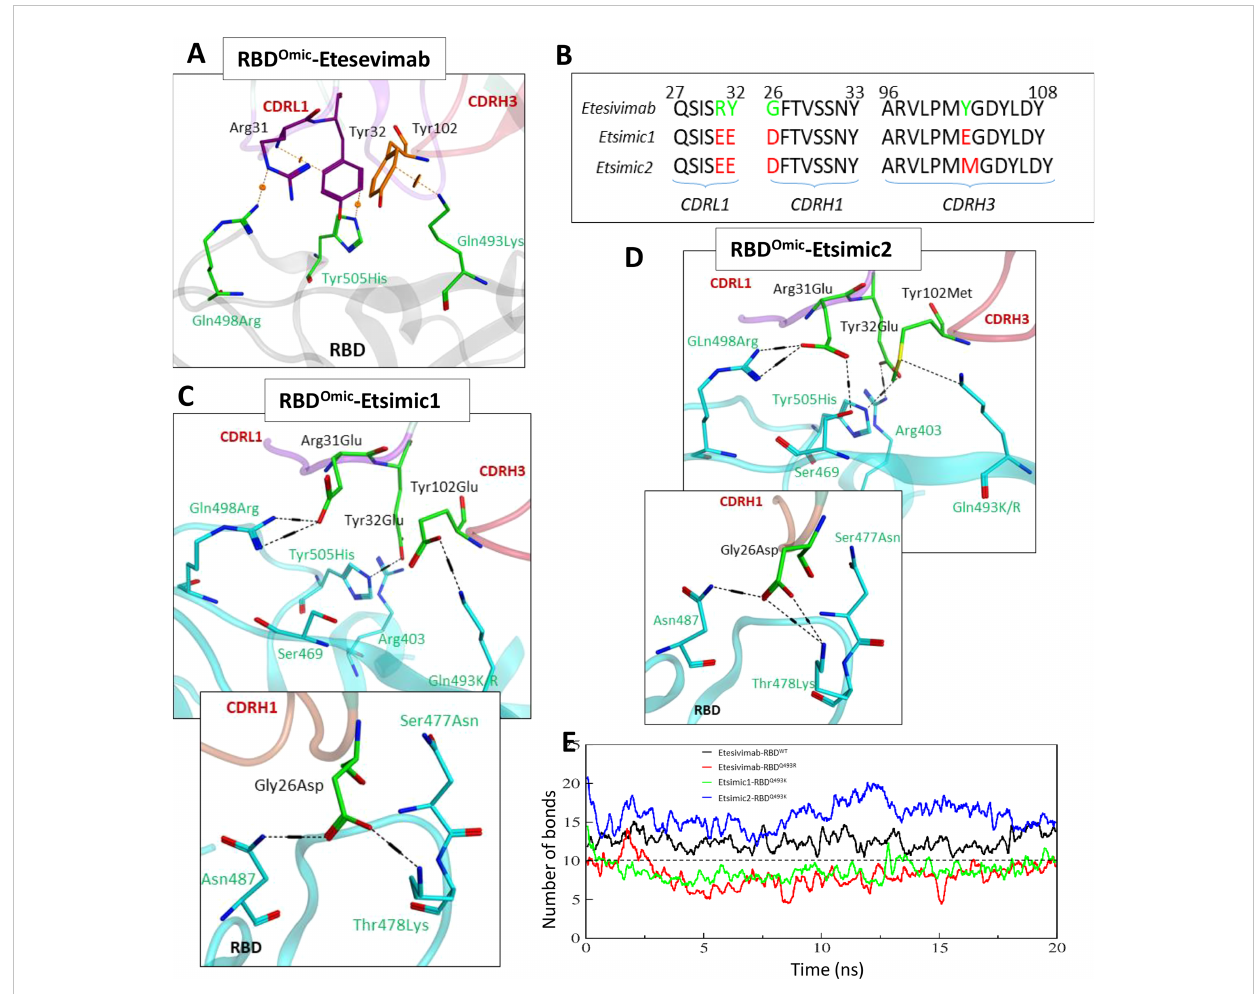
FIGURE 6 Interface analyses and CDR diversi fi cation of the Etesevimab against the Omicron variant. (A) Three mutations in the RBD Omic i.e. Gln493Lys, Gln498Arg, and Tyr505His, abolish vdW contacts at the Etesevimab-RBD Omic interface. (B) Contact favorable mutations created in Etesevimab CDRs (L1, H1, and H3) to restore their ef fi cacy against the Omicron variant. (C, D) Interface analyses of the Etesevimab derivatives (Etsimic1 and Etsimic2) and RBD complexes. Hydrogen bonds are restored and salt bridges are established after CDRL1-Arg31Glu, CDRL1-Tyr32Glu, CDRH1-Gly26Asp, and CDRH3-Tyr102Glu/Met substitutions. Interface contacts along with their bonds-length, bonds-energies and bonds-type of Etsimic1-RBD Omic and Etsimic2-RBD Omic , corresponding to fi gure 6B and 6D are listed in Table S8. (E) Change in the number of hydrogen bonds at the RBD-mAbs interface. The lowest number of bonds was recorded in Etesevimab-RBD Omic(BA.1)